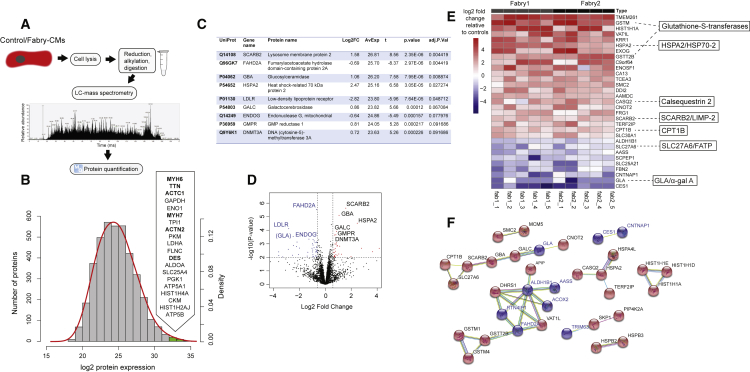
Proteomic Analysis of Control and Fabry CMs(A) Schematic showing the workflow performed for proteome analysis using liquid chromatography-mass spectrometry.(B) Histogram showing the distribution of all detected proteins by their average expression level across all samples (control and Fabry). The red line shows the fitted normal density curve. The top 20 most highly expressed proteins (green bars) are listed in order, with sarcomeric proteins highlighted in bold.(C) “TopTable” output from limma of differentially expressed proteins. Log2FC, log2 fold-change of Fabry samples compared with controls; AvExp, average expression across all samples as log2 value; t, t statistic; adj.P.Val, p value with Benjamini-Hochberg adjustment.(D) Volcano plot showing the results of the limma analysis with significantly upregulated proteins in black and downregulated proteins highlighted in blue. GLA is also highlighted for reference.(E) Heatmap showing protein expression relative to controls in five lysates from each Fabry line, from independent differentiations, for proteins ≥2-fold changed up or down by average in both lines. Some particularly interesting candidates are highlighted to the right.(F) Results of STRING analysis showing potential protein-protein interactions, as run on the 72 differentially expressed proteins in Table S4. Up- and downregulated proteins in Fabry CMs are shown in red and blue, respectively.See also Figure S2.